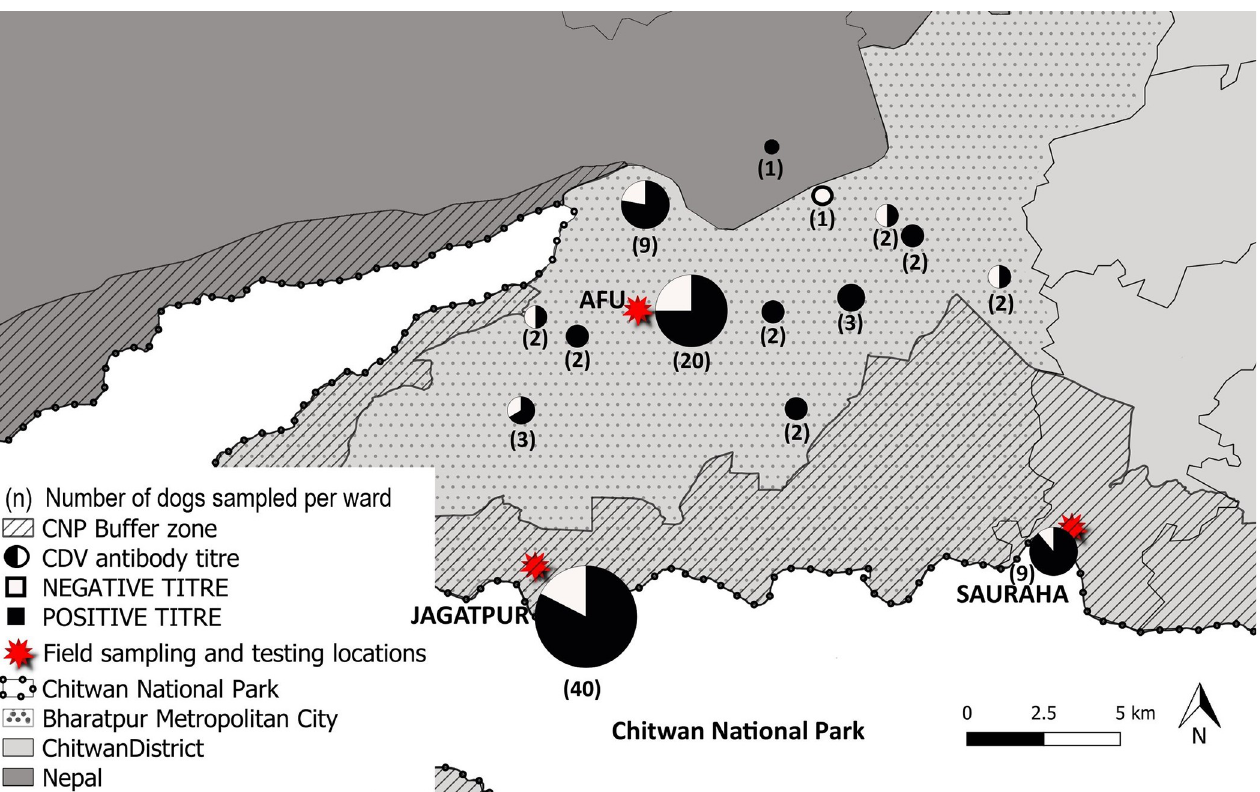
Fig 2. Chitwan District map showing the free-roaming dog canine distemper virus (CDV) seroprevalence results. Field sampling and testing locations are shown in relation to Chitwan National Park (CNP), the buffer zone and Bharatpur Metropolitan City. Seroprevalence results are displayed in pie charts scaled by sample size (black seropositive, white seronegative) at associated ward centroid GPS locations, with the number of dogs sampled from each location displayed in brackets.